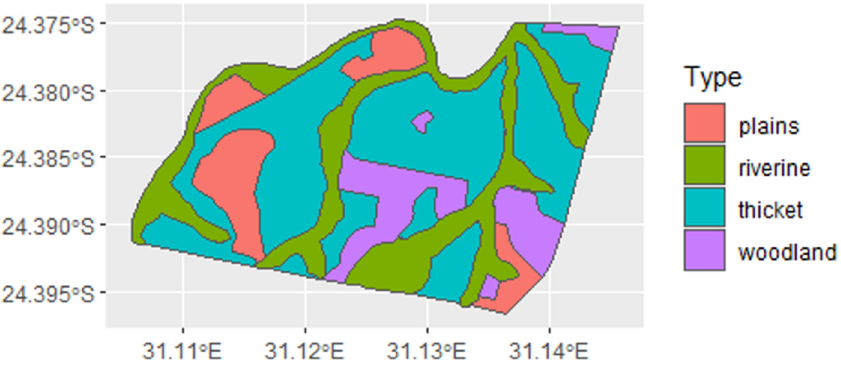
Figure 2. Vegetation map of the Tula Tsau Conservation Area Limpopo, South Africa. The white lion pride and the constructed pride of white and tawny lions both had a similar pride structure with one or more male lions, two or more adult lionesses, and several subadults or cubs (Table 1). Table 1. Pride composition of the Royal pride and the Tsau pride, at the Tula-Tsau Conservation Area (7 Km 2 ) (24°23 ′ S/31°98 ′ E).